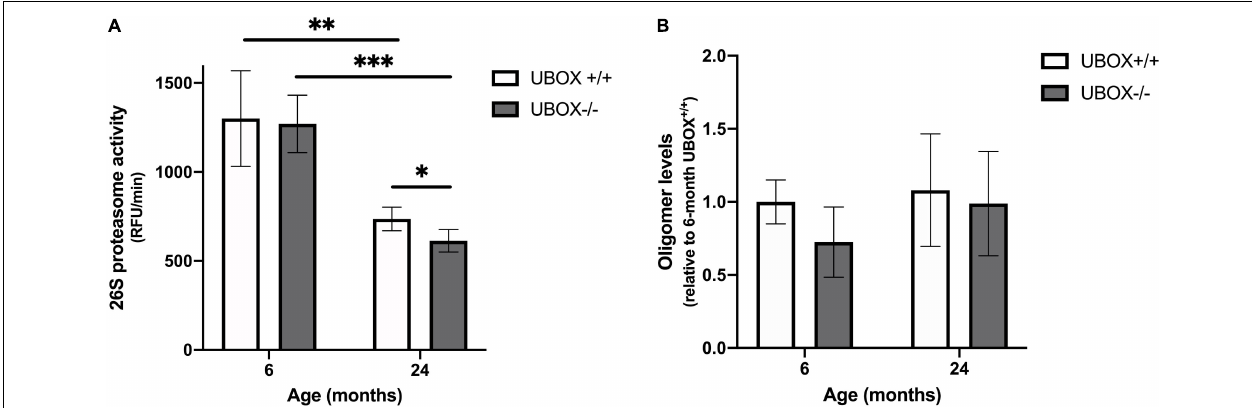
FIGURE 8 | Reduced 26S proteasome activity was detected in U-box − / − fish. (A) Chymotrypsin-like activity was measured in brain tissues of U-box − / − and wild-type fish at 6 and 24 months ( n = 4). Statistically significant differences are shown by asterisks ( ∗ p < 0.05; ∗∗ p < 0.01; ∗∗∗ p < 0.001, Student’s t -test). (B) Oligomer expression quantified from dot blot analysis in brain tissues of U-box − / − and wild-type fish at 6 and 24 months ( n = 3). Data shown are means and error bars indicate standard